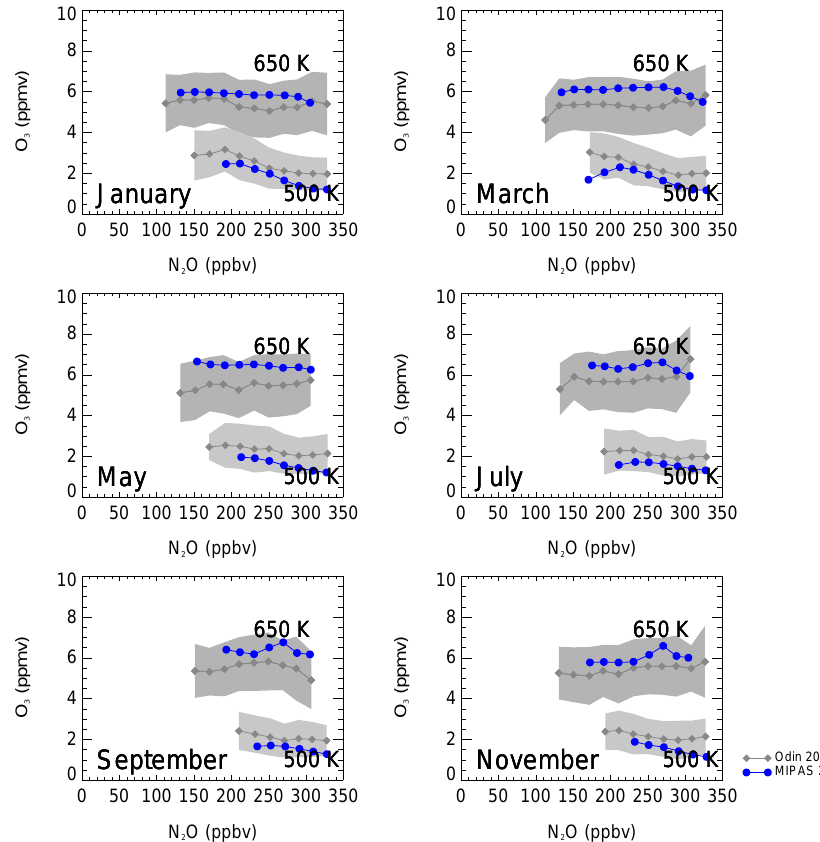
Fig. 11. Comparison of Odin/SMR and ENVISAT/MIPAS monthly averages of N 2 O and O 3 for January, March, May, July, September and November 2003: Odin (grey diamonds) and MIPAS (blue circles).